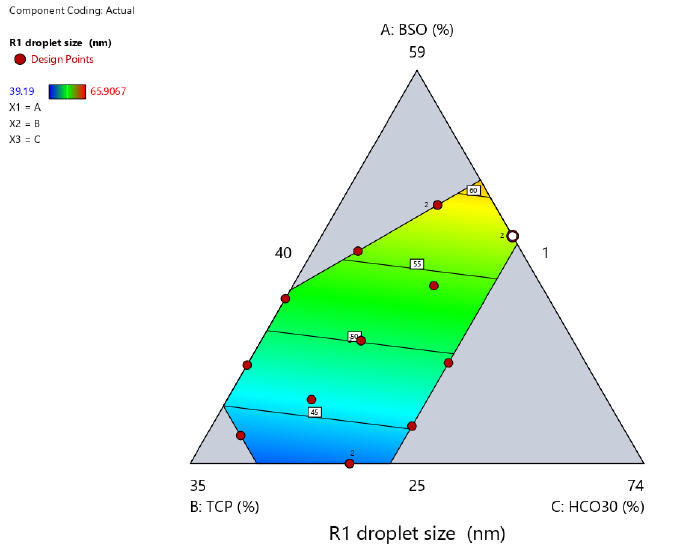
Figure 2. The contour representation of the effects of the formulation components on droplet size.